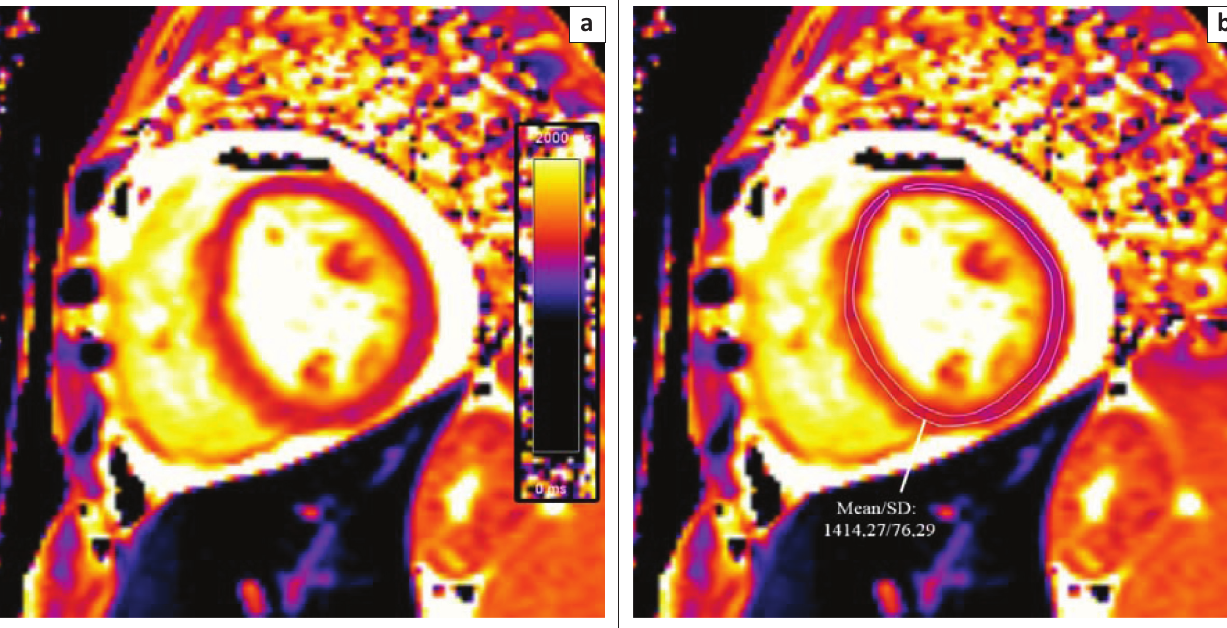
FIGURE 5: T1 map at the level of the mid-LV (a) shows a markedly elevated myocardial T1 time of 1414 m/s (normal 1052 m/s ± 23 m/s at 3 T) (b) in keeping with diffuse myocardial